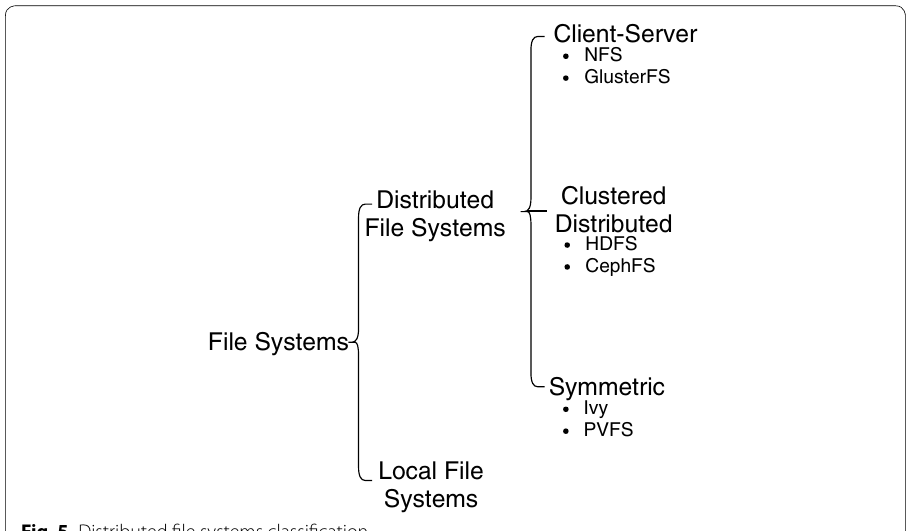
Fig. 5 Distributed file systems